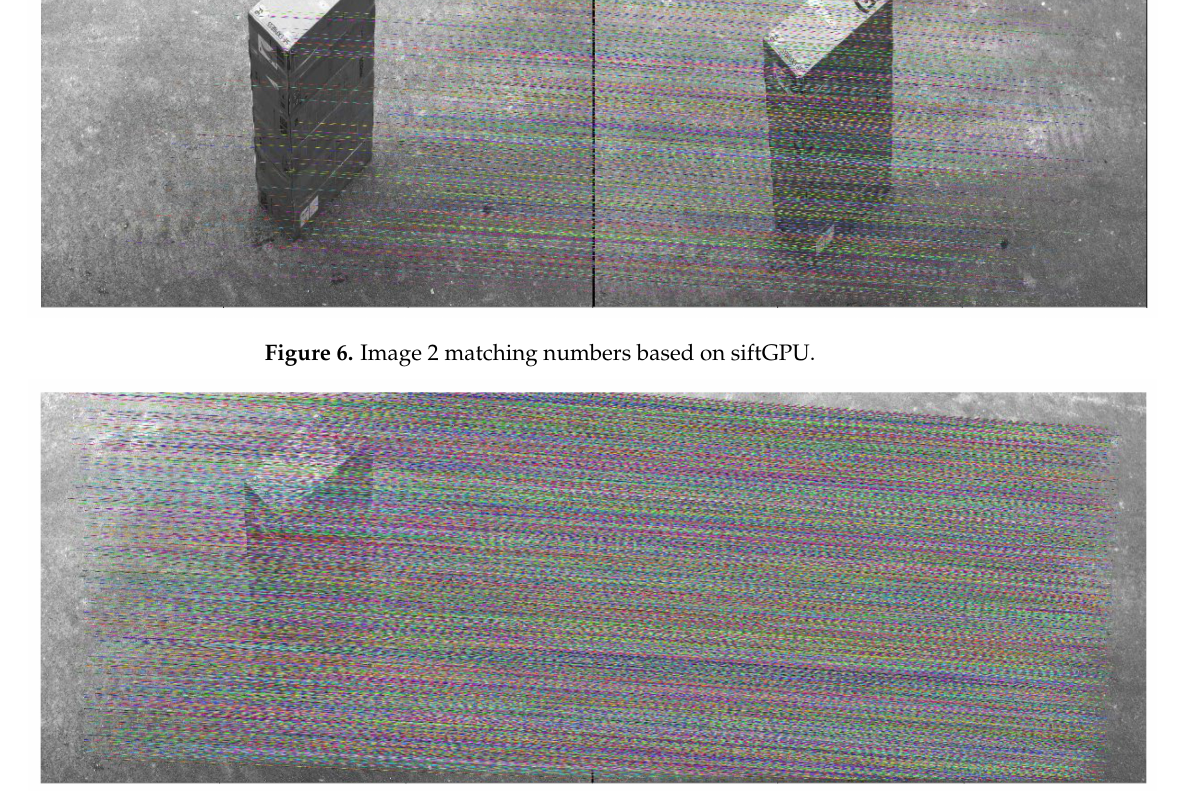
Figure 7. Image 2 matching numbers based on gridding siftGPU.